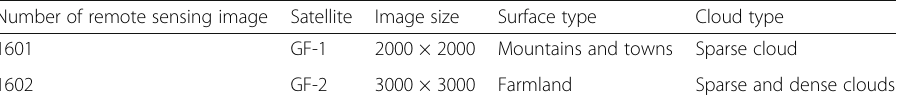
Table 1 Experimental data